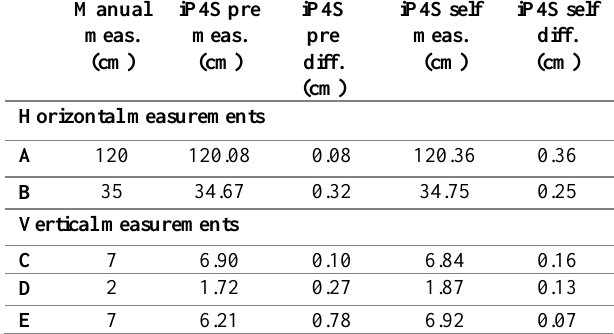
Table 5. Dimensions of curb ramp parameters of interest using 3D point cloud generated with full set of images from iPhone 4S; pre-calibrated camera parameters vs self-calibration procedure.